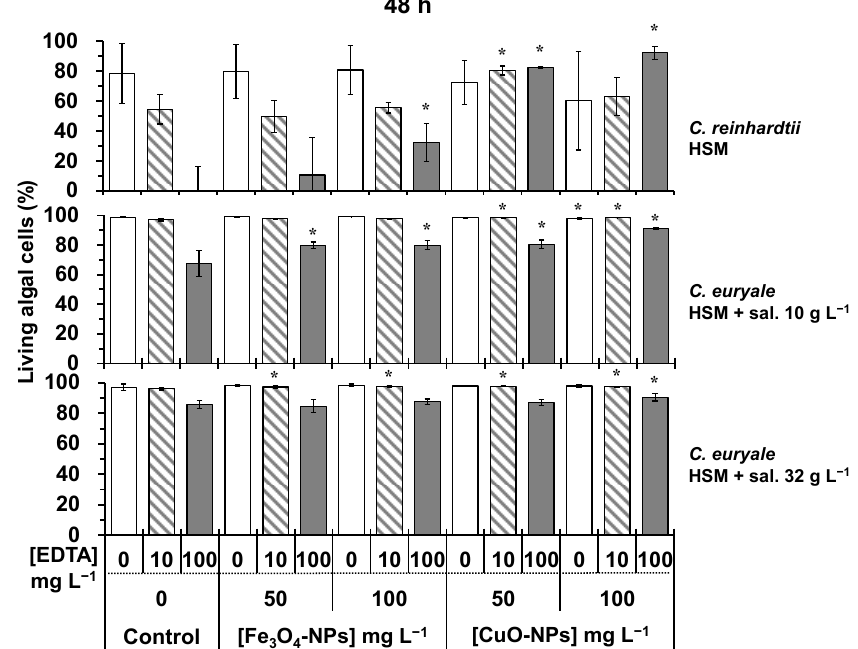
Figure 7. Living algal cells (%) at 48 h for the control and treated cells to 50 and 100 mg L − 1 Fe 3 O 4 -NPs or CuO-NPs: C. reinhardtii in HSM; C. euryale in HSM under two salinity conditions, 10 g L − 1 and 32 g L − 1 . Under these conditions, algal cells were exposed to EDTA concentrations: 0 (white), 10 mg L − 1 (dash), and 100 mg L − 1 (gray). (*) Significant differences between the controls and treatments ( p < 0.05) were determined by one-way ANOVA and Tukey post-hoc test.